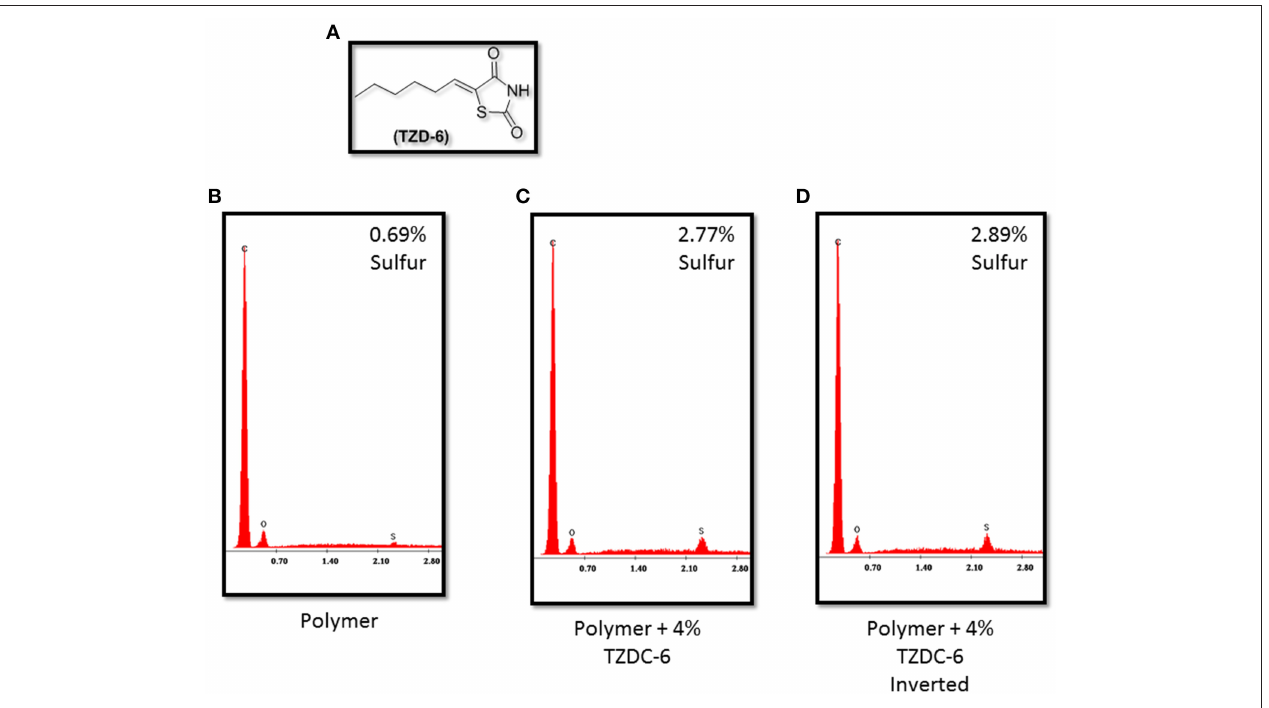
FIGURE 3 | (A) Thiazolidinedione derivative TZDC-6. Energy Dispersive X-ray Spectrometry graphs indicating relative sulfur concentrations in TZDC-6 infused polymers. Naked polymer (B) shows < 0.69% sulfur composition, while both samples coated with TZDC-6 infused polymers (C,D) show similar TZDC-6 concentrations on surface, irregardless of drying angle. Percentage values represent a mean of four different isolated points tested. C, Carbon; O, Oxygen; S,